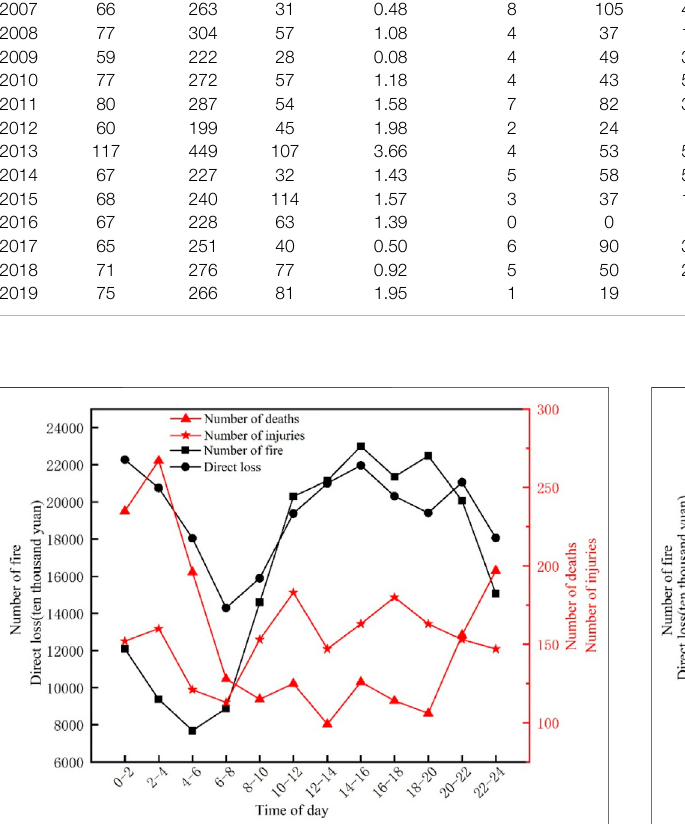
FIGURE 6 | Monthly fi re